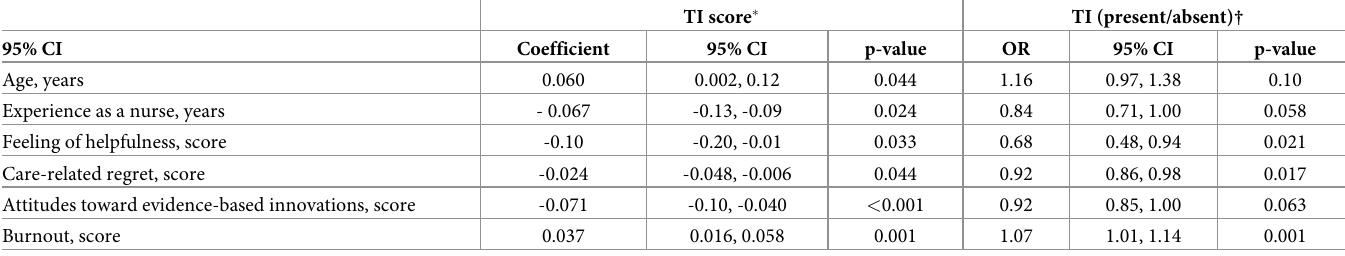
Table 3. Variables associated with TI score and TI